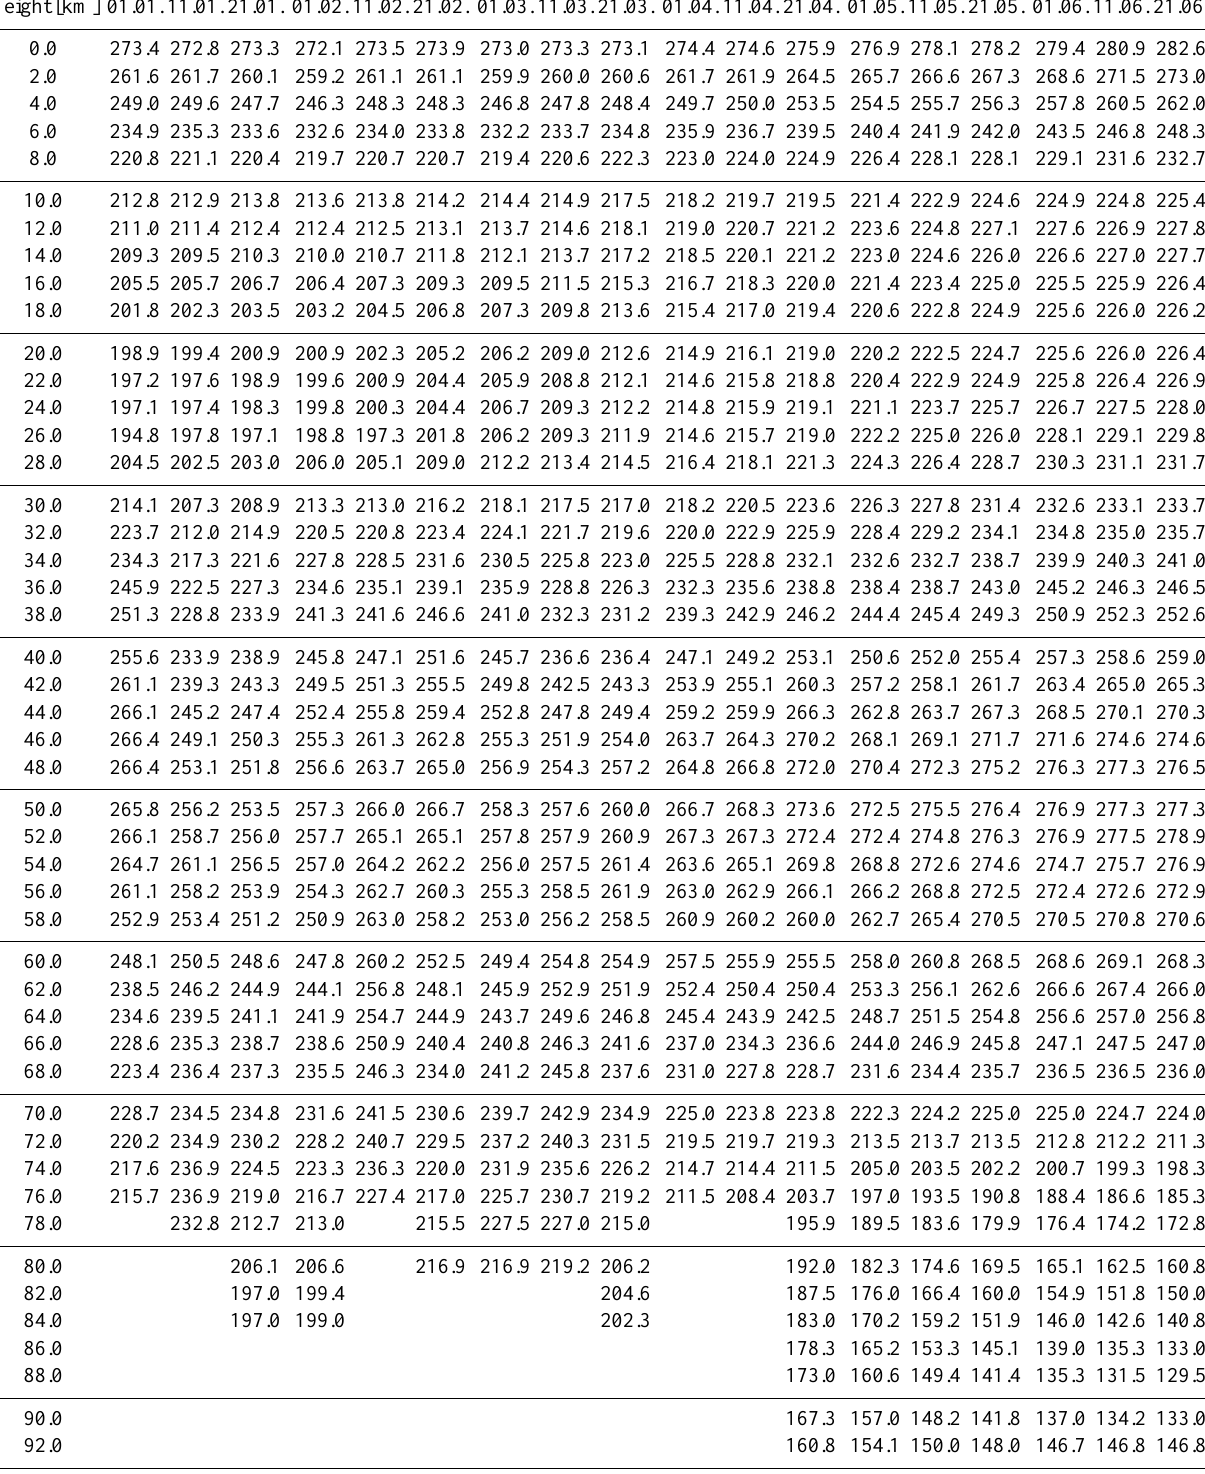
Table B1. Middle atmosphere temperatures in K above ALOMAR from combined RMR lidar, falling sphere and ECMWF profiles (January–June). Temperatures below 30km are from ECMWF at (70 ◦ N, 15 ◦ E) while falling sphere data from the Andøya Rocket Range are used in the summer upper mesosphere (see Sect. 5 for